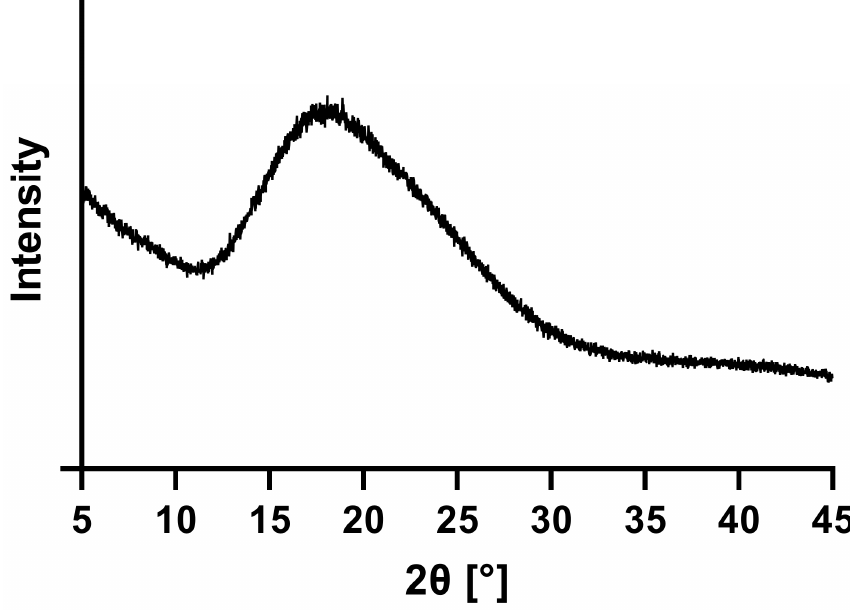
Figure 2. X-ray powder diffraction (XRPD) diffractograms of neat ARCC-4.